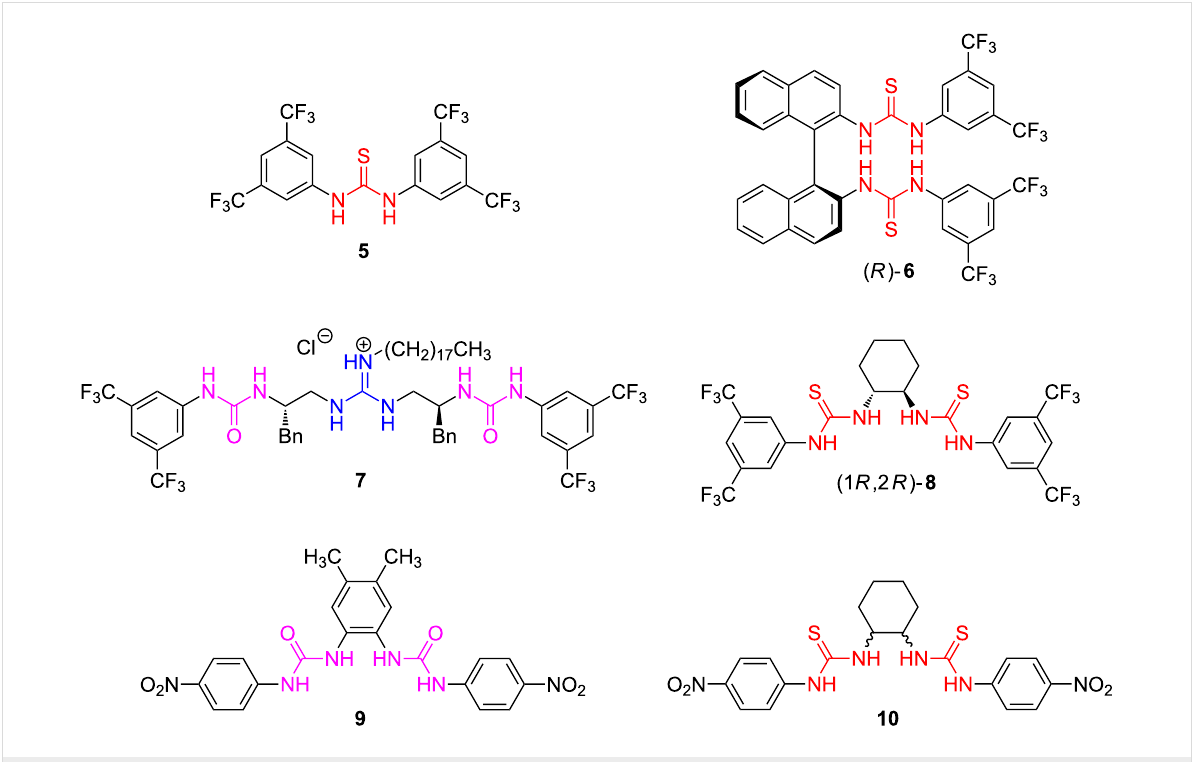
Scheme 2: The structures of some representative (thio)urea and guanidine organocatalysts 5 – 8 and anion sensors 9 and 10